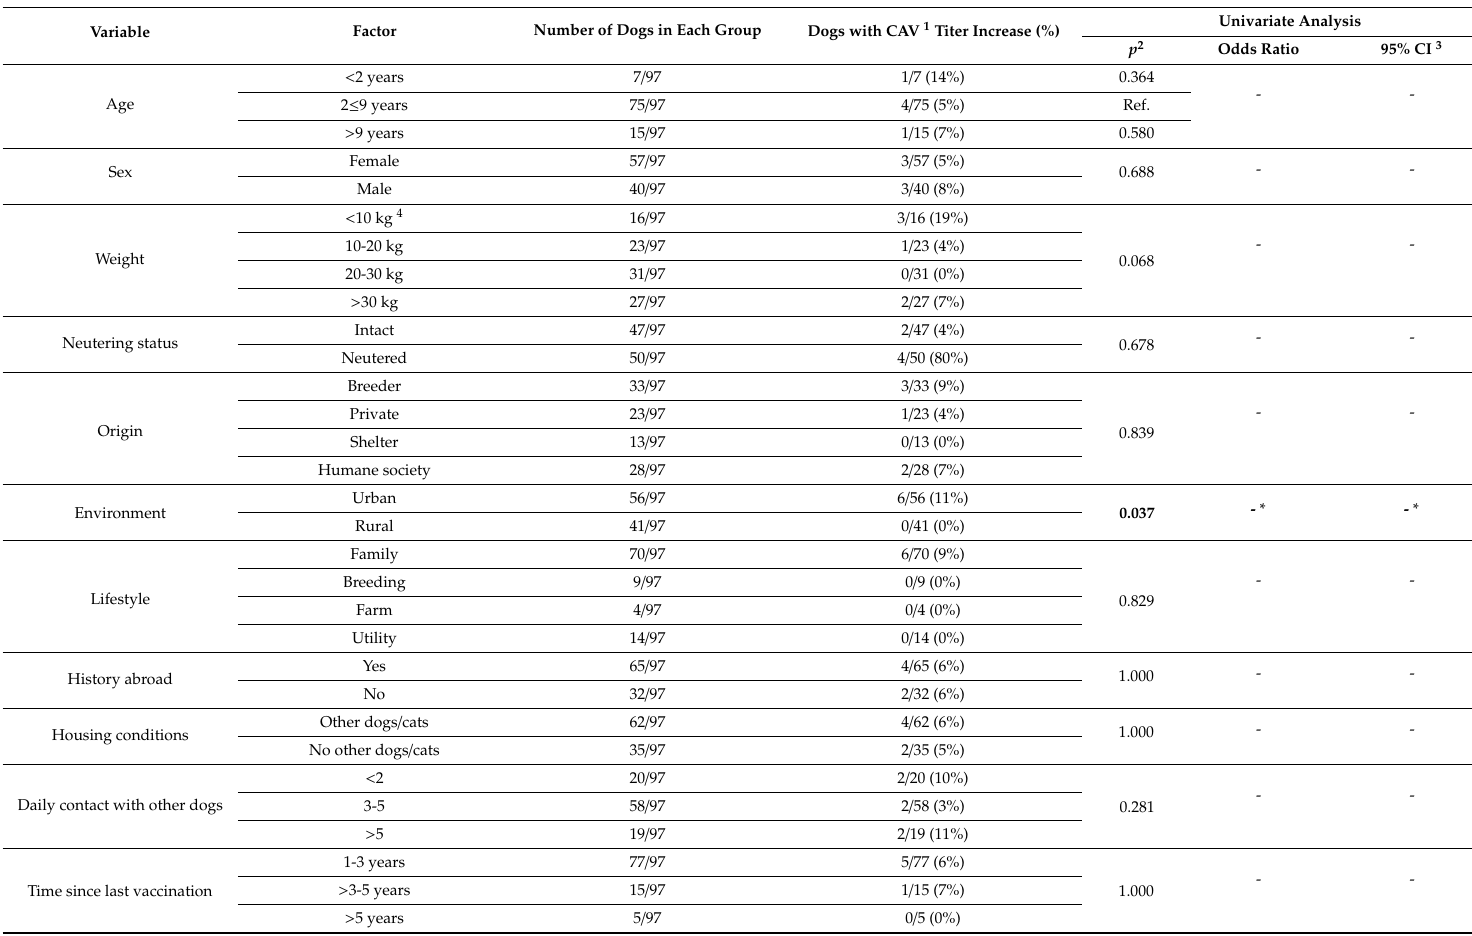
Table 2. Factors associated with the response to vaccination ( ≥ 4-fold titer increase) after modified live canine adenovirus-2 vaccination in univariate